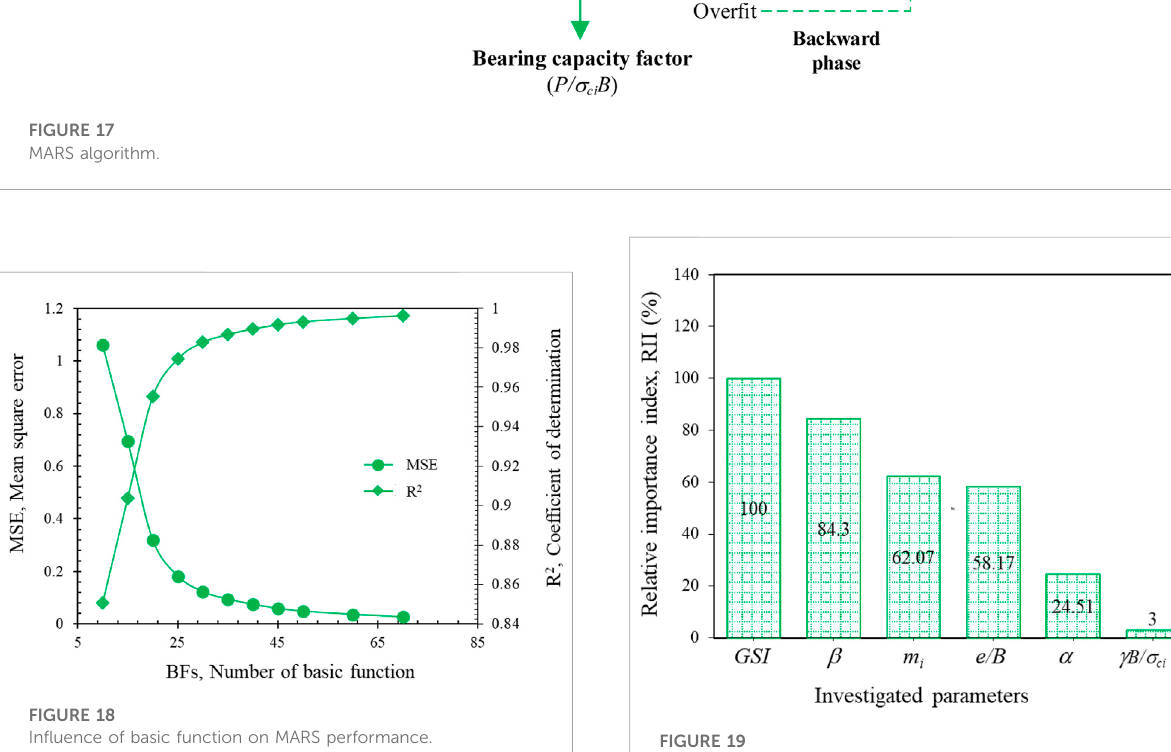
VariationofRelativeImportantIndex, RII onvariousrockmass